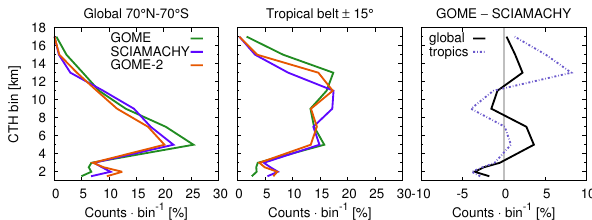
Figure 6.3: Relative pixel count as function of height bin (see Table 6.2) and instrument for (a) global region, (b) tropical belt and (c) count difference between GOME and SCIAMACHY. The coarse GOME footprint favors the detection of high-level clouds over low-level clouds. column-averaged mean cloud top height, because of different weights applied to different layers of the atmosphere. This situation is depicted in Fig. 6.3: retrieval counts (normalized to the total number of counts) are plotted as function of instrument and height bin for global (Fig. 6.3(a)) and tropical belt (Fig. 6.3(b)). GOME senses comparatively half low-level clouds (5% and 2.5% on a global scale and in the tropics, respectively) than SCIAMACHY and GOME-2, which are in good agreement themselves. Especially in